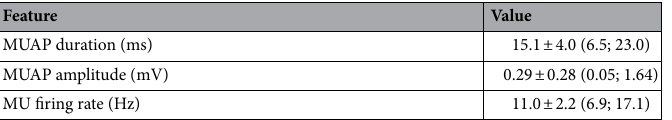
These observations may indicate that these two territories are controlled by the same innervating motor neuron (i.e., the same MU), although they are 20 mm apart (Fig. 5a,d). This finding is in contrast to previous studies